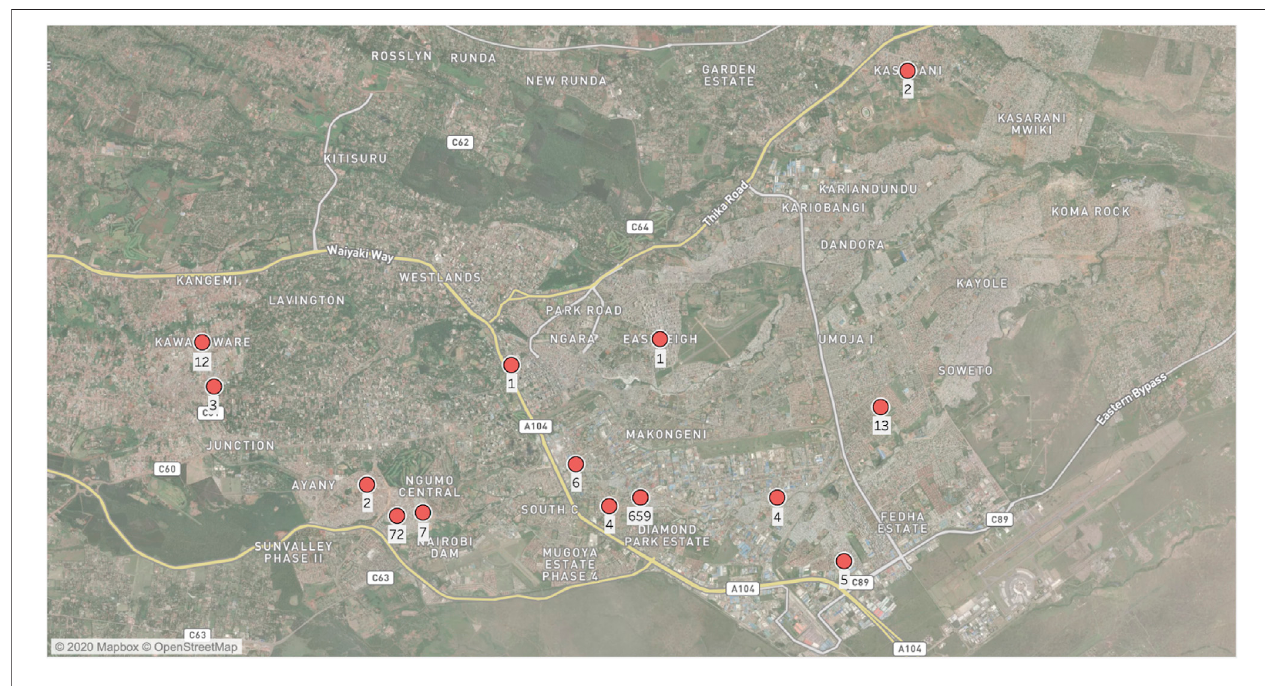
FIGURE 6 | Location clusters of sample units in Nairobi.